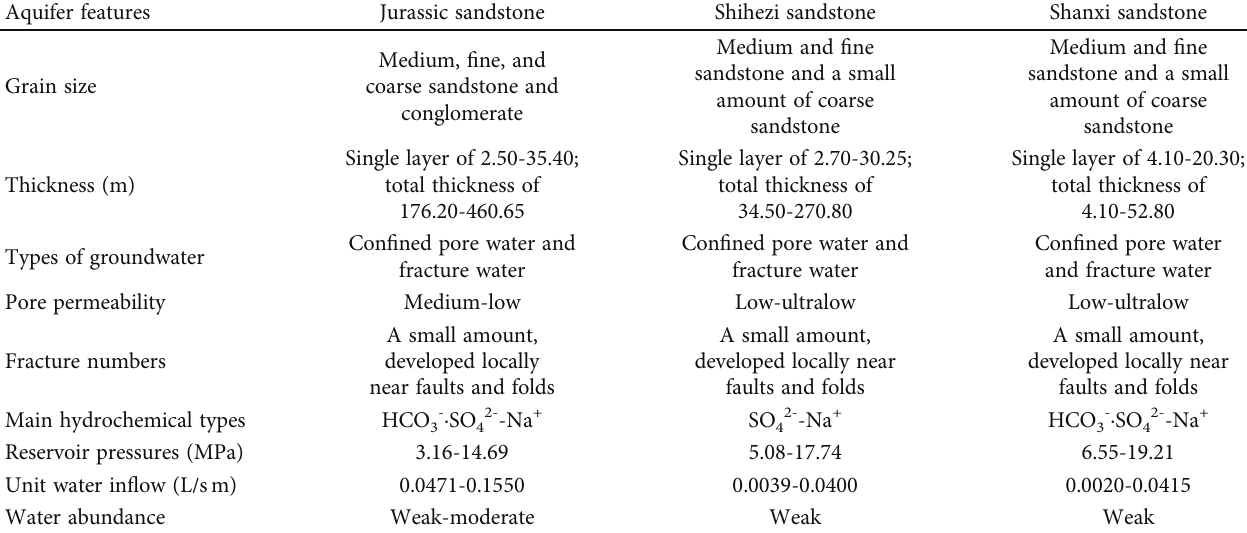
Table 5: Hydrogeological features of three layers of sandstone